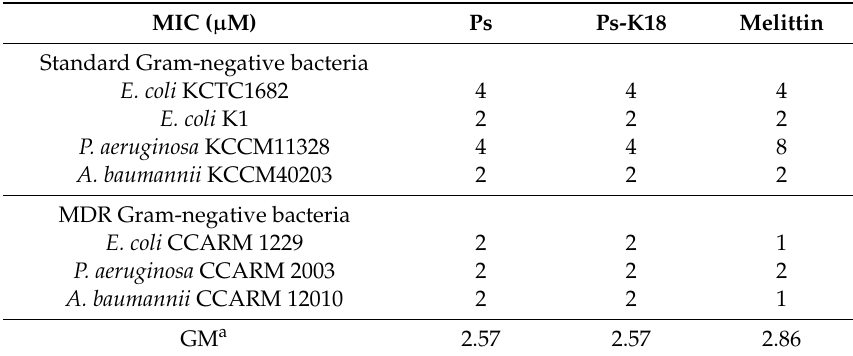
Table 2. Antimicrobial activities of the Ps and Ps-K18 against standard bacterial strains and MDR bacterial strains. MIC ( µ M)